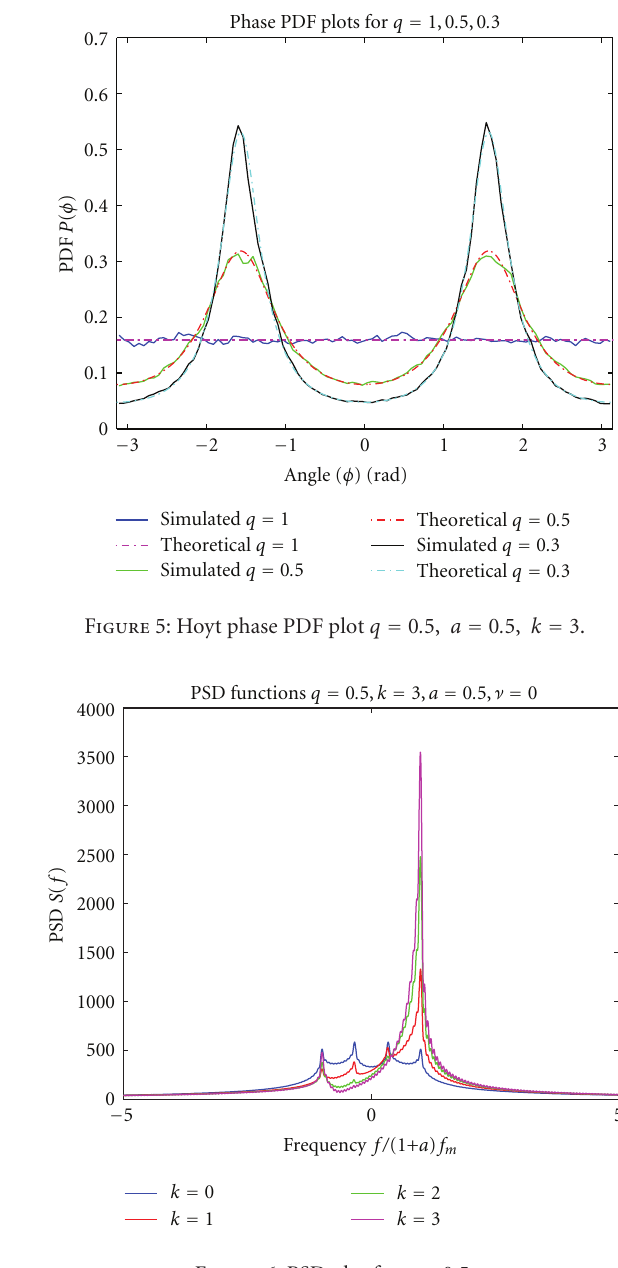
Figure 6: PSD plot for q = 0 .